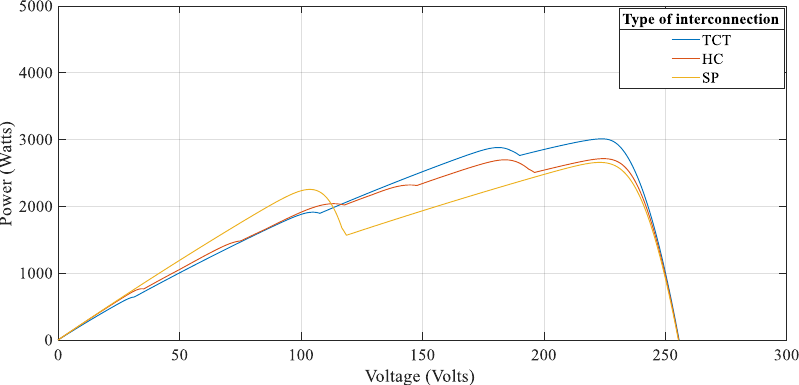
(cid:48) (monocrystalline